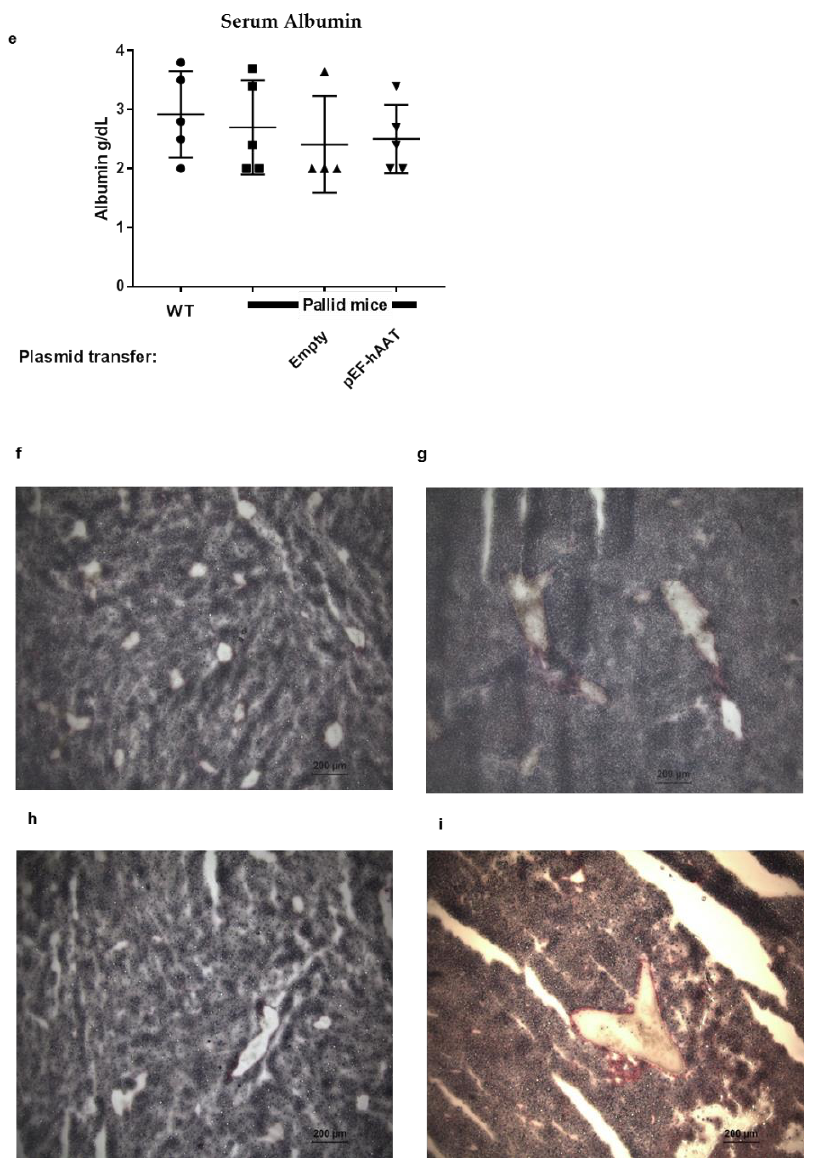
Figure 1. Human alpha1 antitrypsin (AAT) expression 30 days after in vivo intrahepatic electroporation-mediated hAAT gene transfer: ( a ) hAAT levels in serum and liver homogenates, mean ± SD; ( b ) representative immunofluorescent images of the liver 30 days after intrahepatic electroporation-mediated gene transfer, green fluorescence: hAAT. Electroporation-mediated gene transfer is safe in the liver. Serum levels of liver enzymes were measured: ( c ) serum aspartate aminotransferase (AST), ( d ) serum alanine aminotransferase (ALT), and ( e ) serum albumin. Values are expressed as mean and ± SD; all the values are within physiological range. Sirius red staining of the liver section did not show any sign of liver injury or fibrosis after electroporation-mediated gene transfer as observed by Ishak system staining [23]. Wildtype ( f ), pallid ( g ), empty vector ( h ), and pEF-hAAT ( i ).